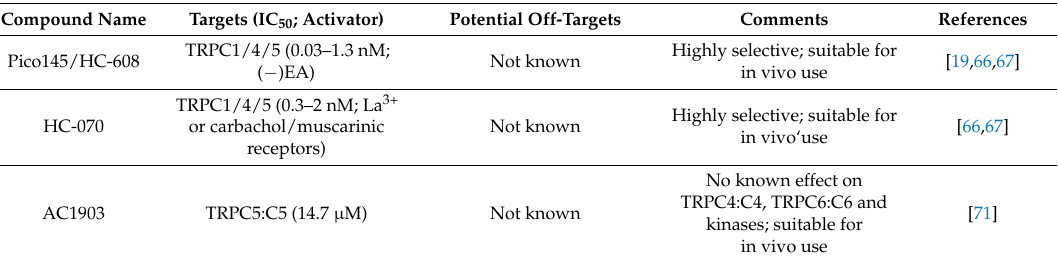
Table 2. Overview of selected TRPC1/4/5